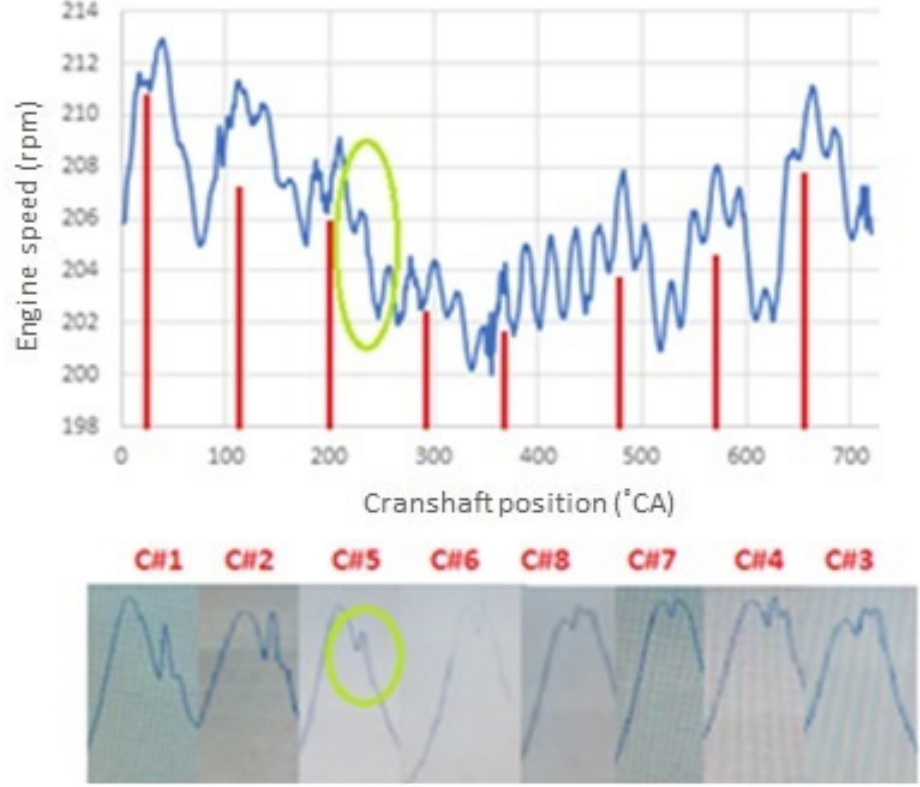
Figure 11. Example of the instantaneous rotational speed and combustion pressure as a function of crank angle.